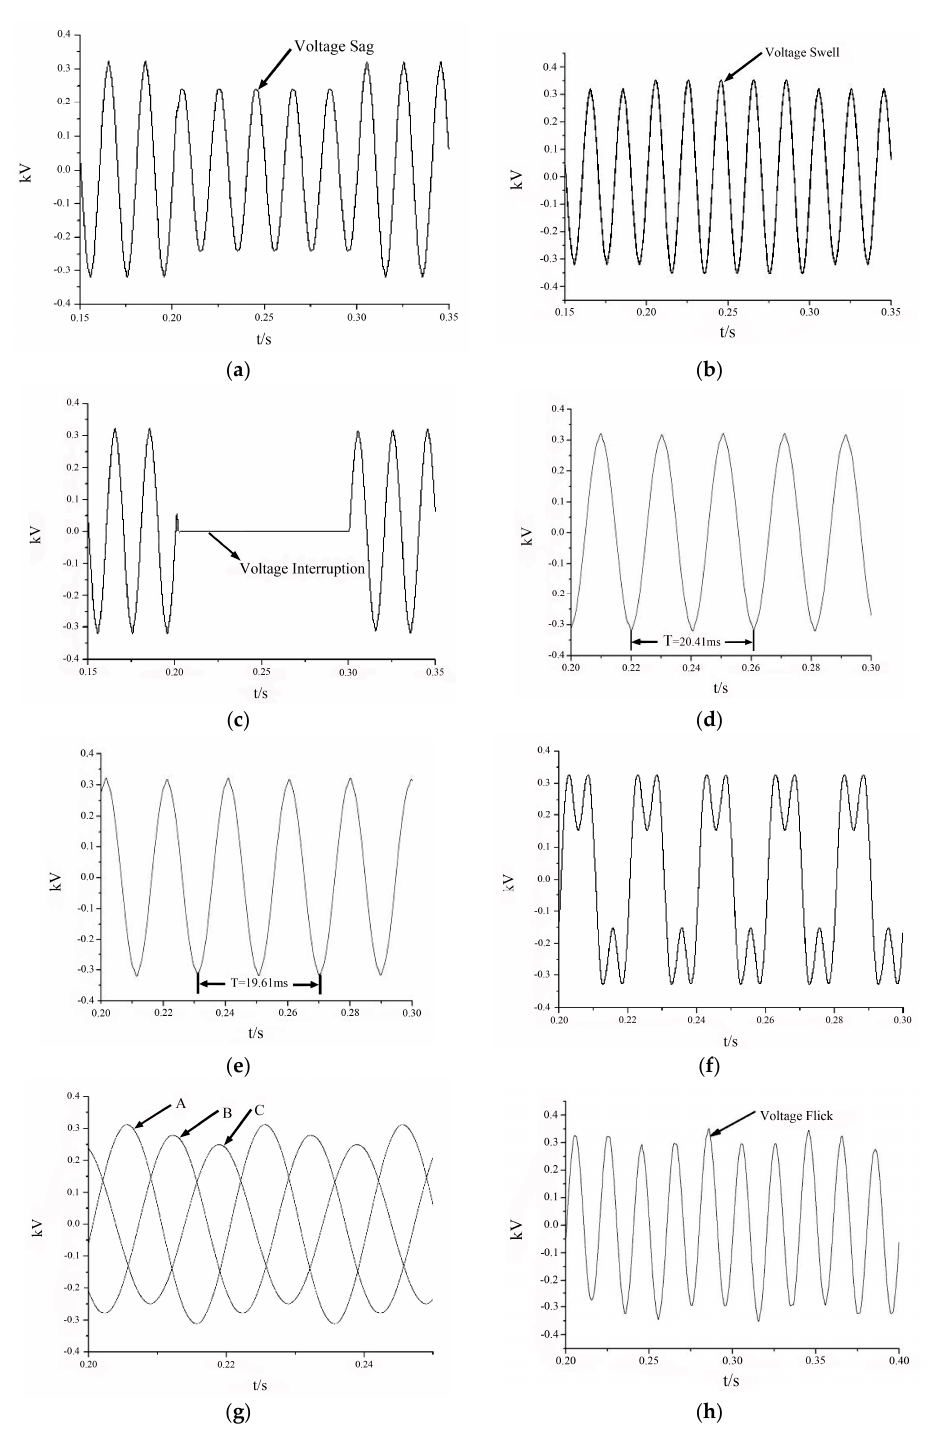
Figure 13. ( a ) Voltage sag; ( b ) voltage swell; ( c ) voltage interruption; ( d ) waveform of 49 Hz; ( e ) waveform of 51 Hz; ( f ) harmonic injection; ( g ) 3-phase unbalanced waveform; ( h ) voltage flick.